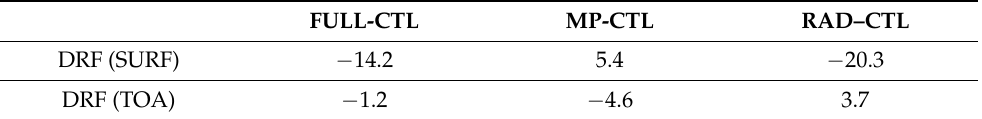
Table 10. Area average of mean dust radiative forcing (DRF) at the surface (SURF) [Equation (4)] and top of atmosphere (TOA) [Equation (5)]. Units are W m − 2